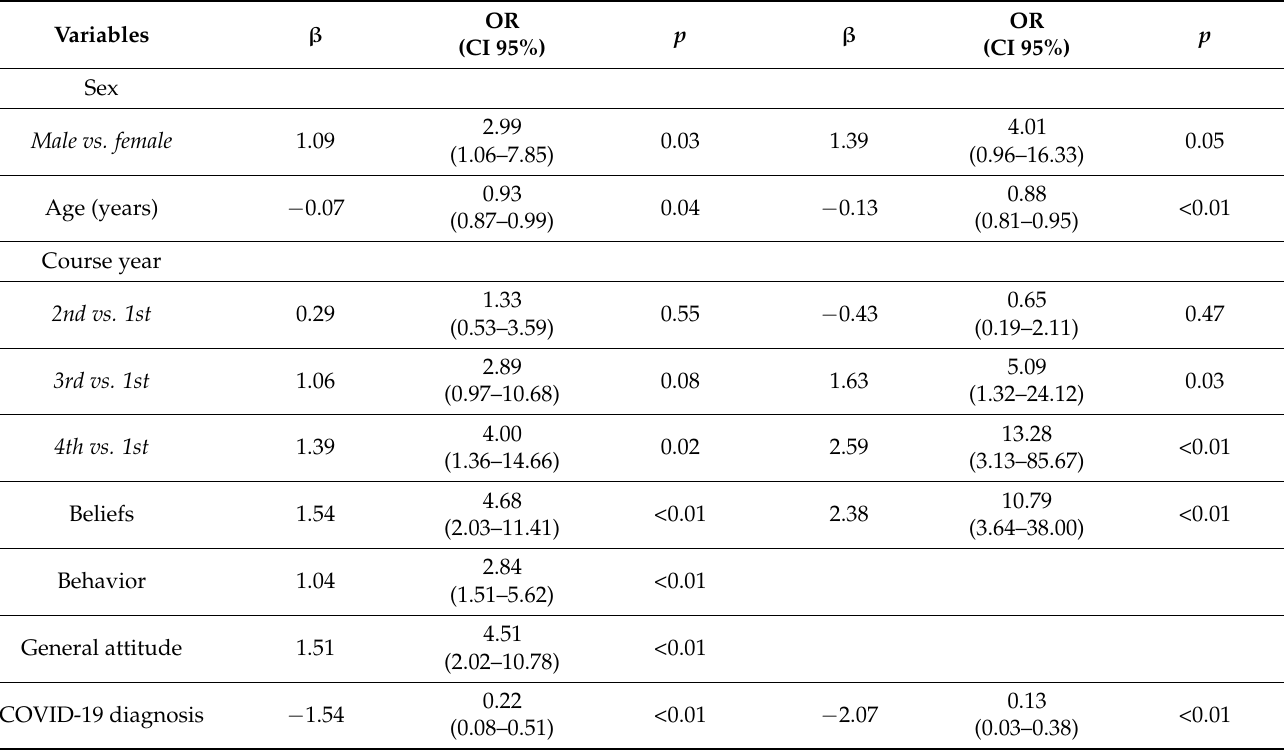
Table 4. Univariable and multivariable binary logistic (best model) regression results considering COVID-19 vaccination status as the dependent